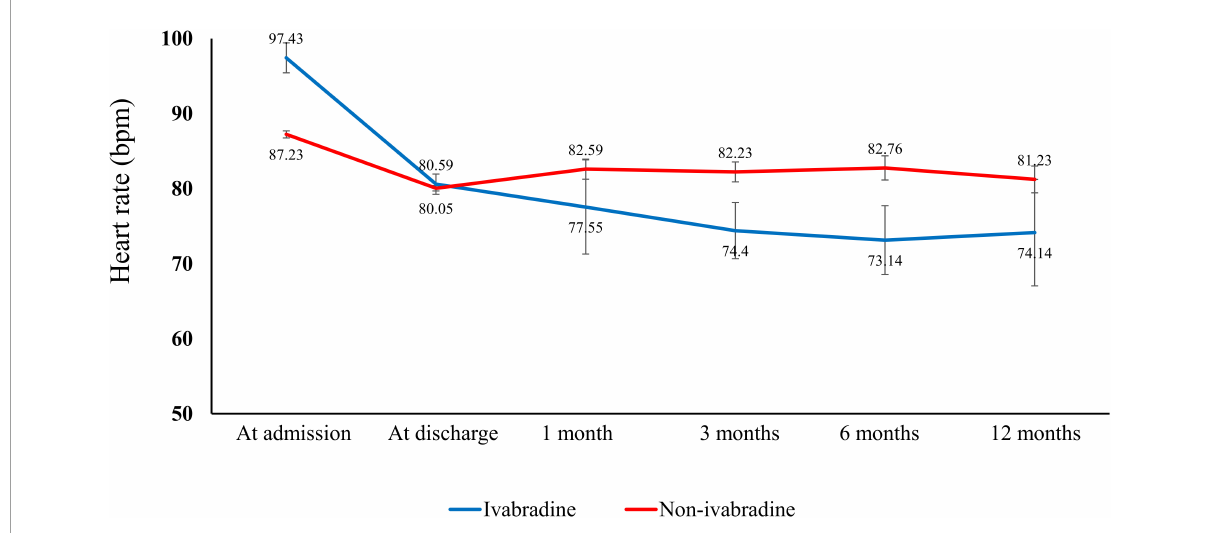
FIGURE2 Heart rate in the index admission and observation period. There was a higher heart rate in the ivabradine group than in the non-ivabradine group at admission. However, the heart rate was lower in the ivabradine group after